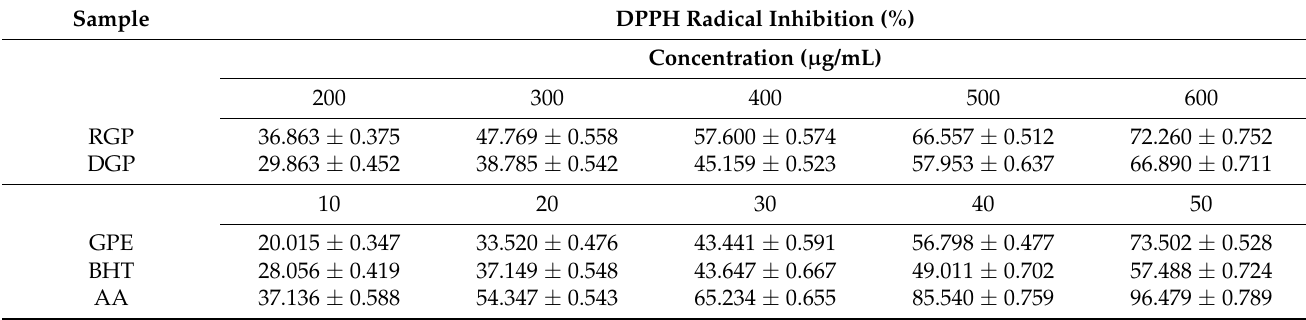
Table 2. DPPH radical inhibition (%) achieved by different concentrations of the sample.